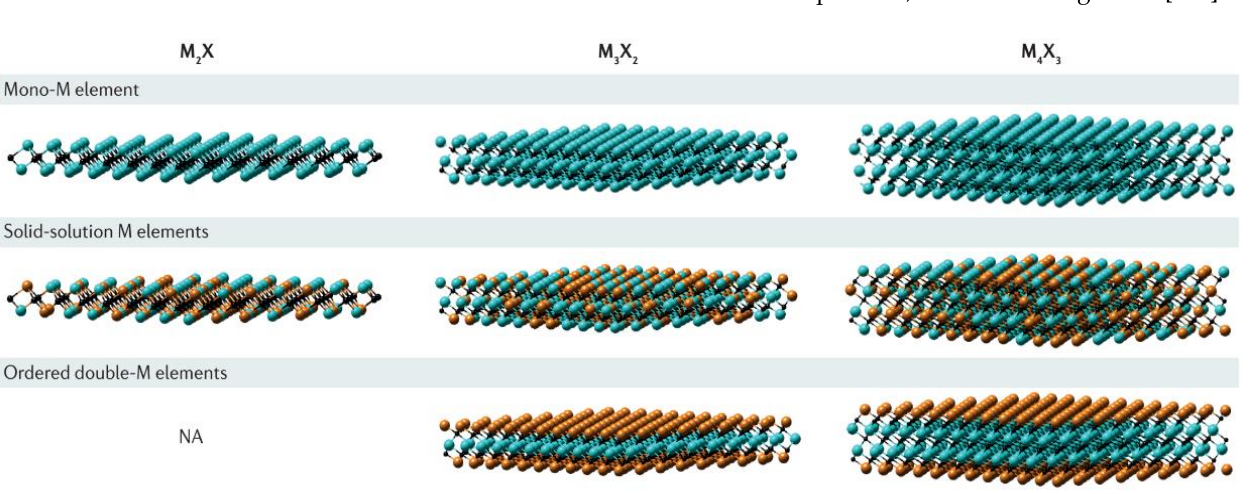
Figure 10. Typical layered structures of MXenes. (Reproduced with permission from ref. [161]. Copyright 2017 Springer Nature Publications.).